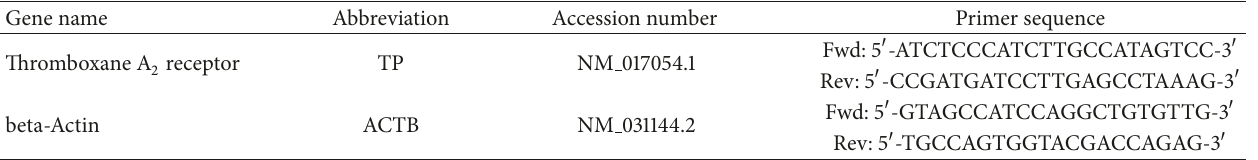
Table 1: Accession numbers and primer sequence for the genes that were